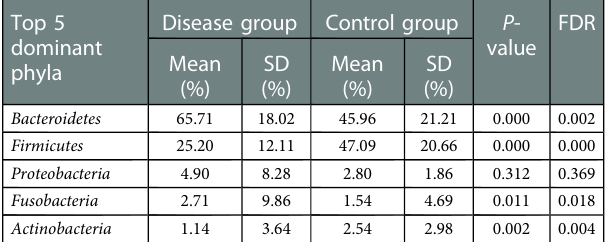
Table 2 Analysis of dominant bacteria in children in the disease and control groups (top